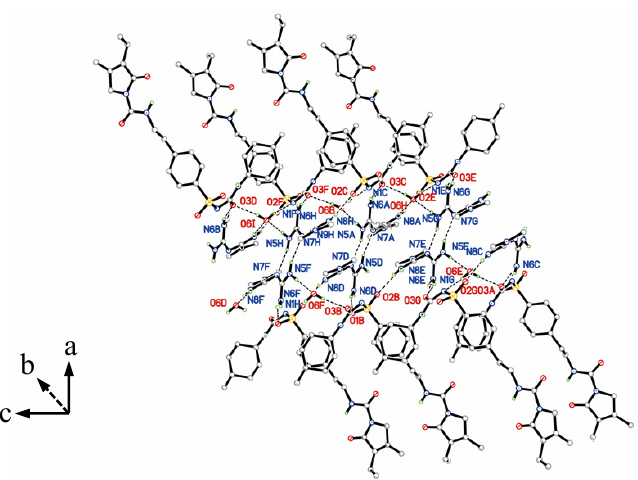
Figure 5. Two dimensional layered structure connected by hydrogen bonds of Gli-Met.